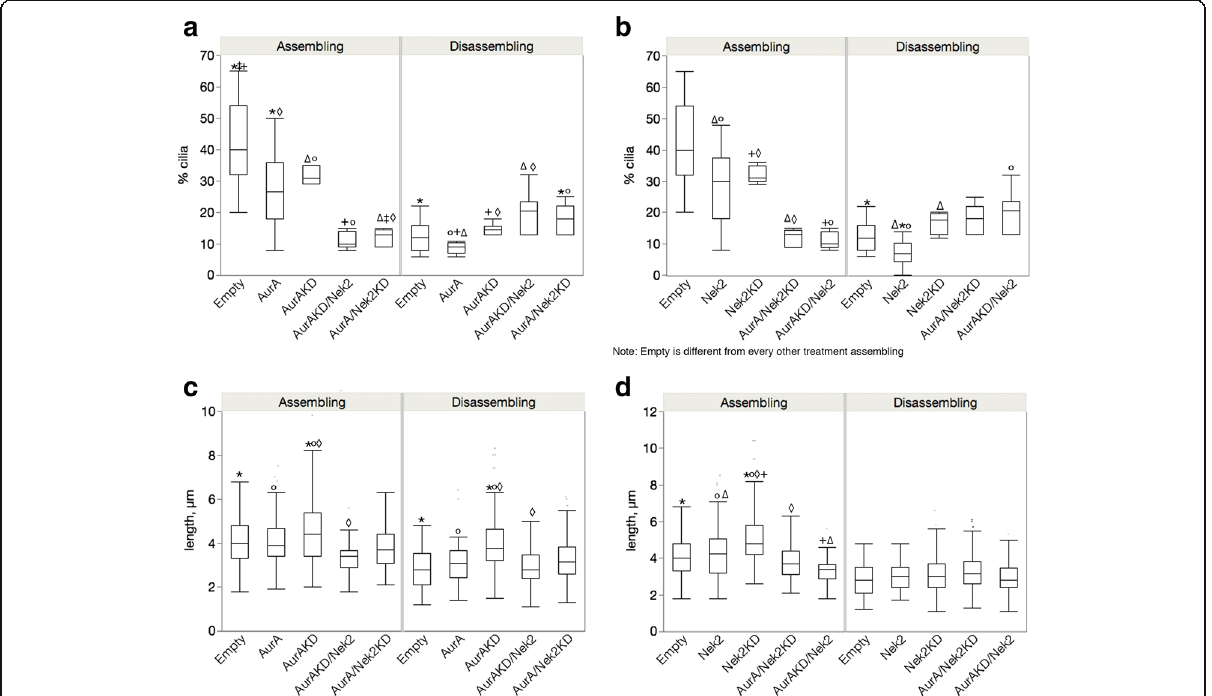
Fig. 1 The effect of active kinase and dominant negative enzymes alone or in combination. ARPE-19 cells were transfected individually with AurA, AurAKD (kinase dead dominant negative), Nek2 and Nek2KD (kinase dead dominant negative), AurKD/Nek2, AurA/Nek2KD. Cilia number ( a and b ) and length ( c and d ) were measured for the AurA single and cotransfectants ( a and c ) and the Nek2 single and double transfectants ( b and d ). Measurements were made when cells were serum starved for 48 h (assembling cilia, left panels) and refed serum for 24 h (disassembling cilia, right panels). 300 cells were counted. Significant differences are indicated by like symbols; p ≤ 0.05. Empty vector is significantly different from all other transfectants when cilia are assembling. The means for cilia number and length ± SEM are shown in Table